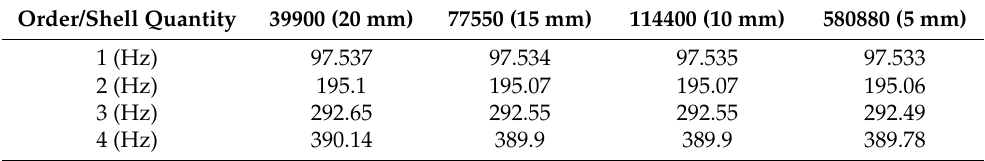
Table 4. Comparison of simulated values of the first four acoustic modes with different mesh sizes. Order/Shell Quantity